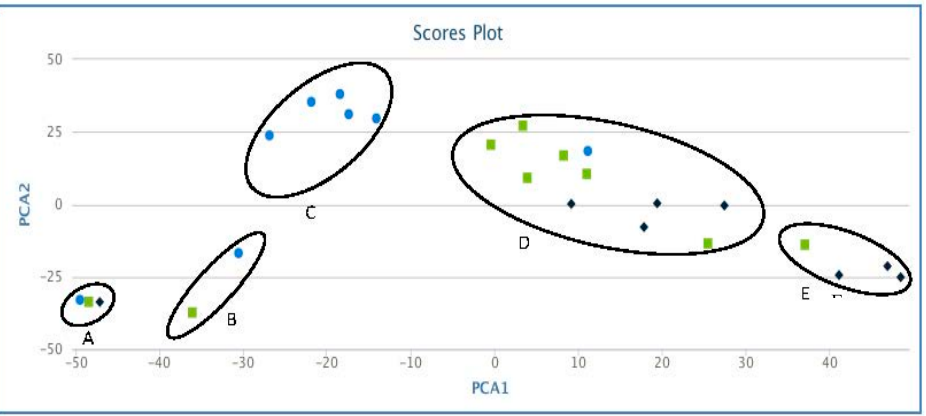
Figure 4. Principal component analysis (PCA), revealing the correlations between a variety of pyrolytic lignins (derived from fast pyrolysis). PCA plot was generated using XCMS bioinformatics platform for metabolomics. Clusters: Group A phenolics content (1–5 mg gallic acid equivalents (GAE)/g of pyrolytic lignin (PyL), Group B phenolics content (5–15 mg GAE equivalents/g of PyL), Group C, D, and E phenolics content ( ≥ 15 mg GAE equivalents/g of PyL).